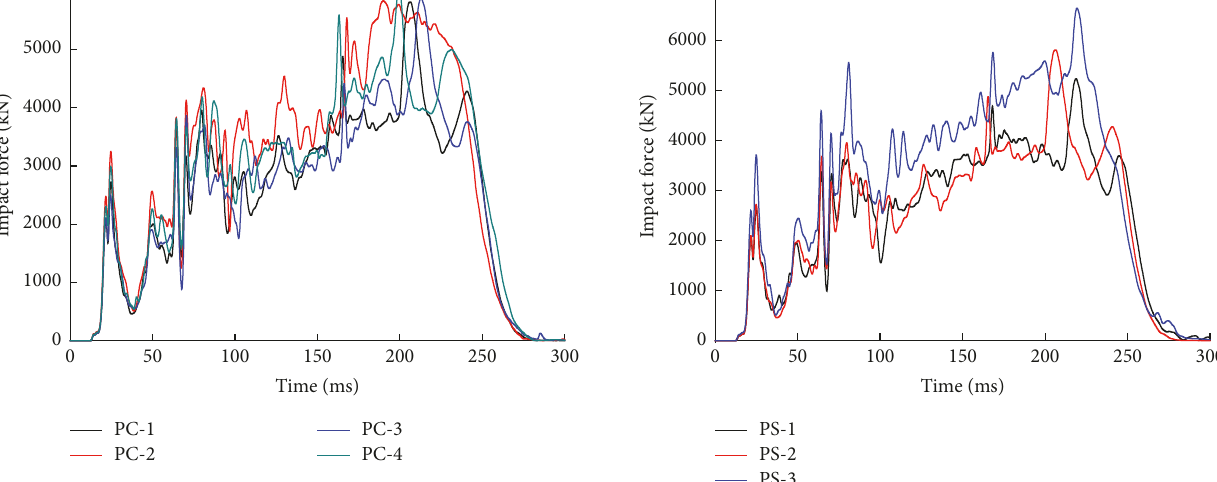
Figure 20: Impact force time-history curves under different con- crete strengths.